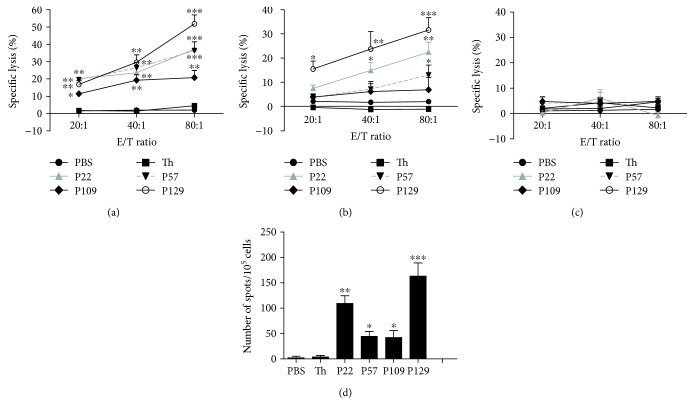
Specific lysis of target cells and secretion of IFN-γ by induced CTLs in immunizing HLA-A2.1/Kb transgenic mice immunized with the indicated peptides. Peptide (100 μg) and the IAb-restricted HBV-core128 T helper epitope (140 μg) emulsified in IFA were used to immunize HLA-A2.1/Kb transgenic mice on days 0, 5, and 10. PBS only or T helper peptide emulsified in IFA was used as the negative control. On day 11, we isolated splenocytes from the mice and restimulated the cells with 10 μg/ml peptide and 10 U/ml rmIL-2 to repriming these splenocytes in vitro for additional 6 days. An LDH assay was performed to assess the lysis activity of the induced CTLs toward (a) SW620 cells (HLA-A2+, MTA1+), (b) T2 cells pulsed with each peptide, and (c) SW620 cells incubated with an anti-human HLA-A2 antibody (HLA-A2−, MTA1+). IFN-γ secretion was detected by the ELISPOT assay. (d) T2 cells incubated with each peptide and an irrelevant peptide (50 μg/ml) for 4 h were used as the stimulating cells. Each sample was measured in triplicate. Data represent means ± SD (n = 5). ∗
P < 0.05, ∗∗
P < 0.05, and ∗∗∗
P < 0.001 vs. the T helper epitope group.